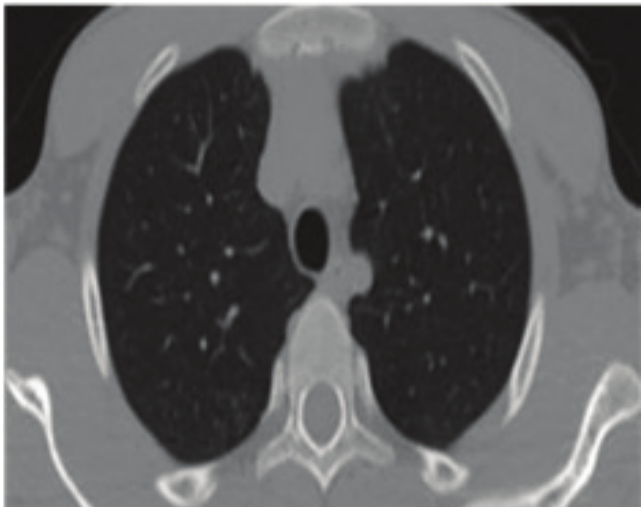
Figure 3 - The CT of thorax performed after the one-month follow up.